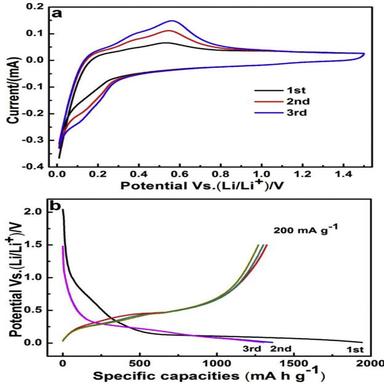
(a) CV curves for the first three cycles of the MP-Si/Ni/C anode at a scan rate of 0.1 mV s¡1 in the voltage range of 0.01e1.5 V versus Li/Liþ. (b) Galvanostatic charge-discharge profiles at 200 mA g¡1 for the first three cycles.